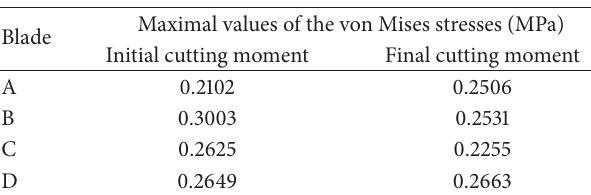
Table 4: Simulation result.